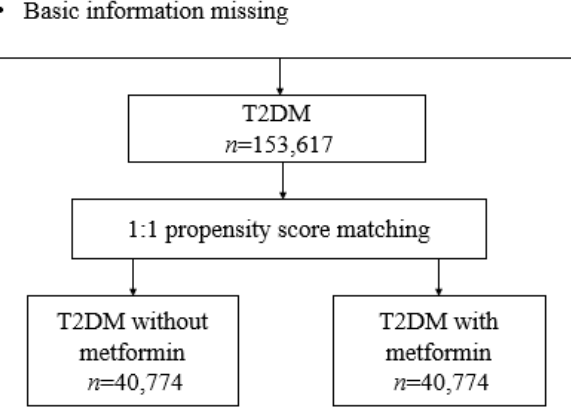
Figure 1. Flow chart of the identified process in this